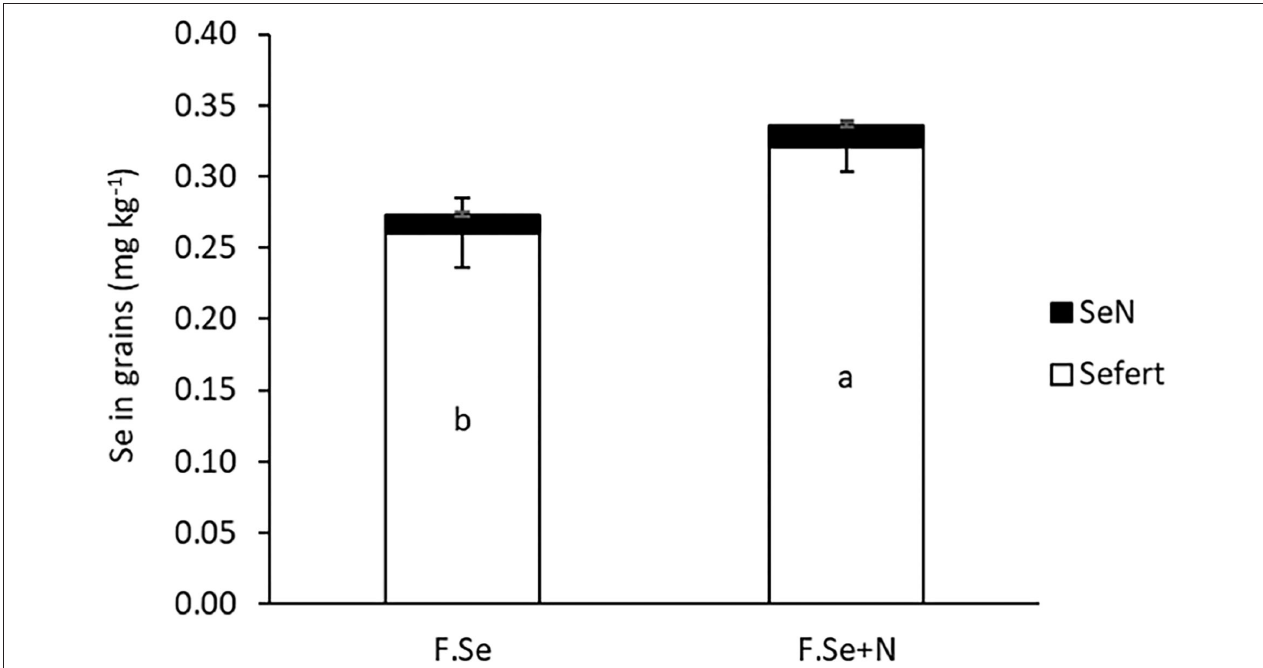
FIGURE 3 | The concentration of native and fertiliser-derived Se in wheat grains. Error bars represent SEs ( n = 4). “a” and “b” represent statistical differences in means at the p = 0.05 level.